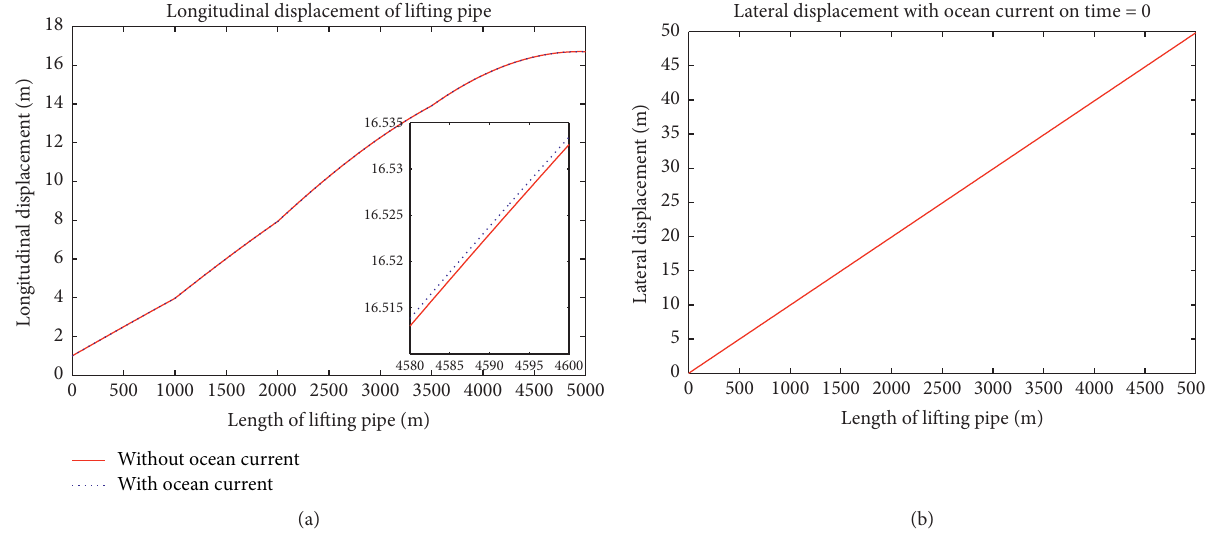
Figure 5: Longitudinal and lateral displacement of lifting pipe. (a) Longitudinal displacement. (b) Lateral displacement.